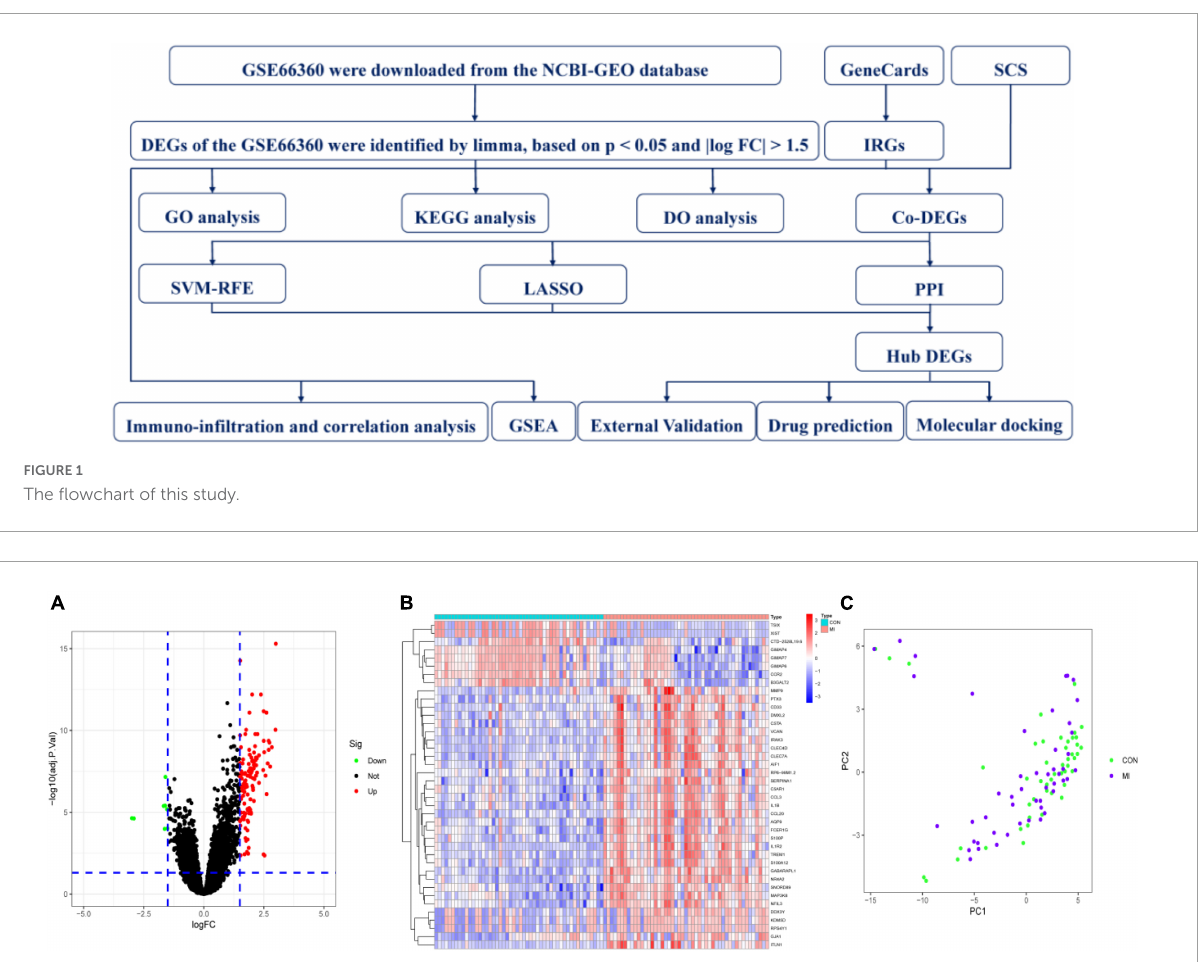
FIGURE2 Identification of DEGs. (A) The volcano plot presented the DEGs between MI and CON groups. The upregulated genes are labeled in red, and the downregulated genes are labeled in green. (B) The heatmap visualized the alterations in the expression of DEGs. (C) PCA of DEGs showed good differentiation